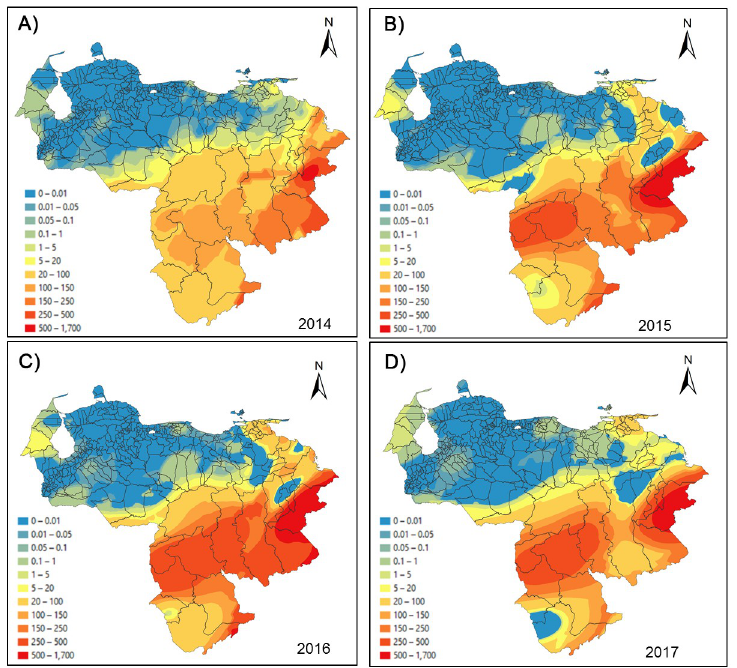
Fig 7. Spatial prediction maps (malaria risk) for 2014 (A), 2015 (B), 2016 (C) and 2017 (D) years derived from the ordinary gaussian kriging interpolation model of the annual parasite incidence (API). Note Year 2017, data available only through Epidemiology Week 21. Maps were created with the ArcGIS desktop software